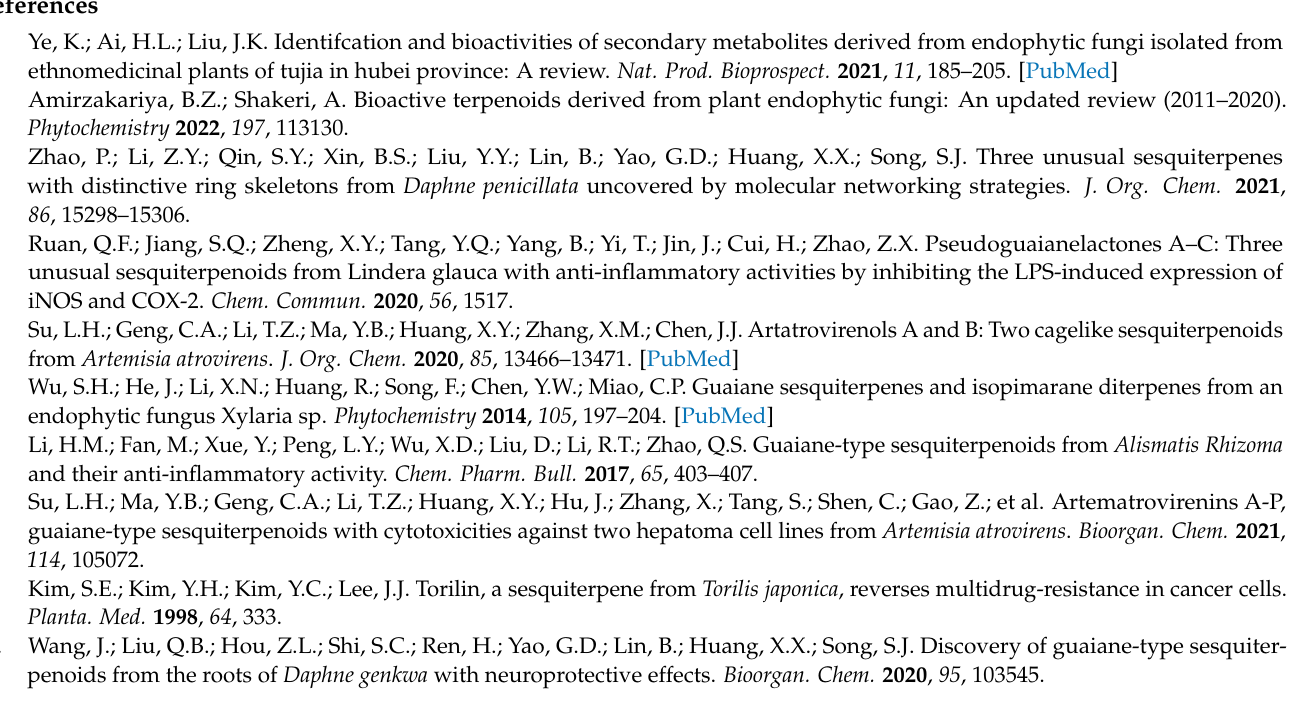
Table S11. Gibbs free energiesa and equilibrium populationsb of low-energy conformers of compound 7 , Table S12. Cartesian coordinates for the low-energy reoptimized random research conformers of compound 7 at B3LYP-D3(BJ)/6-31G* level of theory in